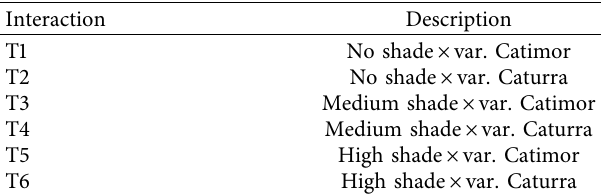
Table 1: Description of generated interactions. Te interactions were between shade levels (high ≥ 40% shade, med � up to 40% shade, no shade � full sun) and cofee variety (Caturra and